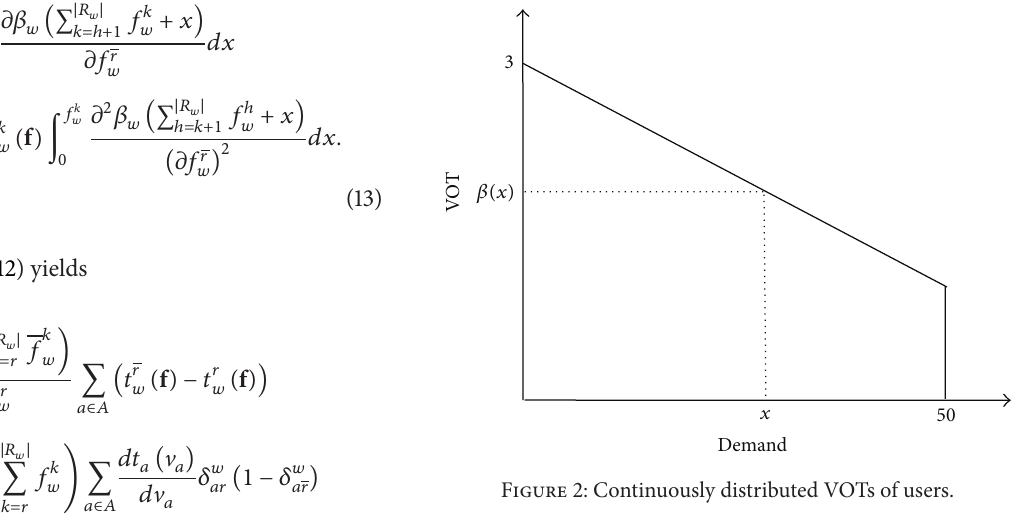
Figure 2: Continuously distributed VOTs of